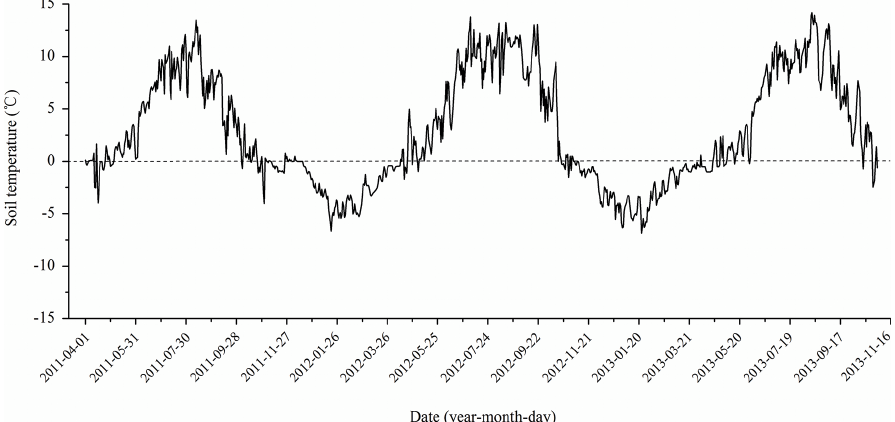
Figure 2. Mean daily soil temperature in the alpine meadow from April 2011 to October 2013. Thermochron iButton data loggers were placed at 10cm soil depth to obtain automatic readings every 1h, and the mean daily soil temperature was calculated every day.